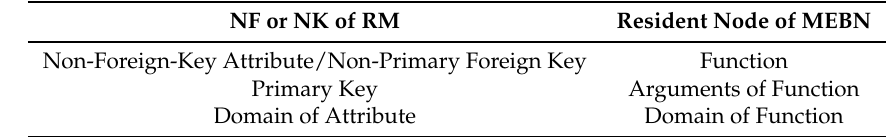
Table 3. Function Mapping in